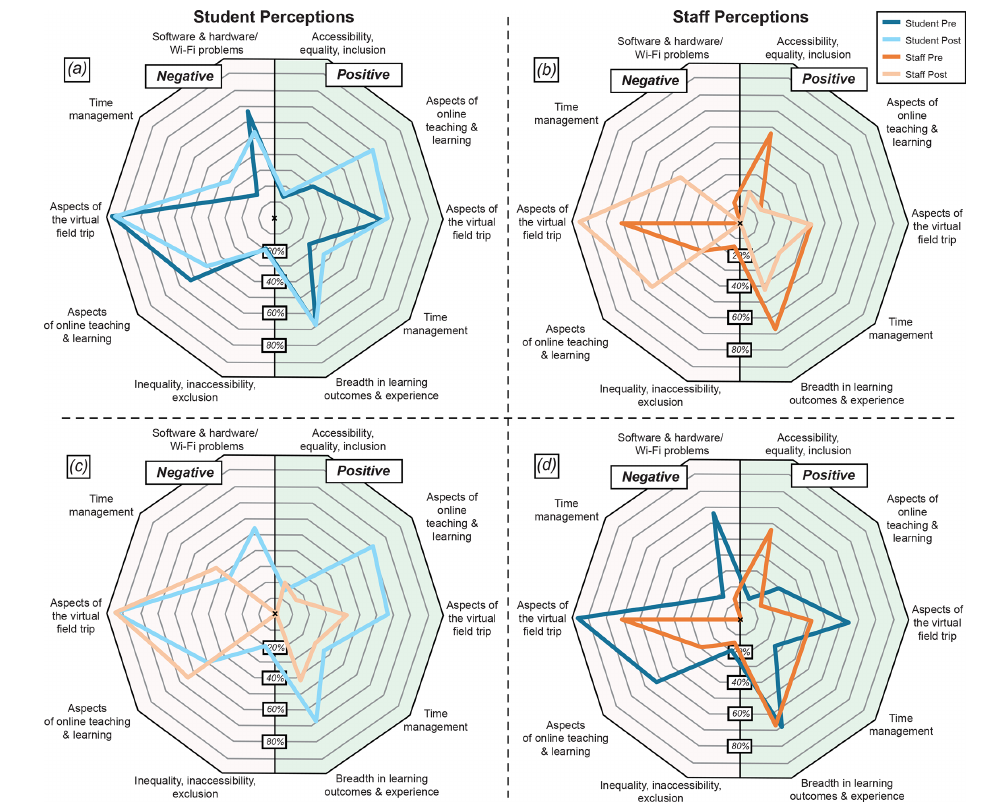
Figure 5. Radar plots of student and staff perceptions derived from free-text responses to questions: (a) student perceptions pre-course ( n = 20) and post-course ( n = 14), (b) staff perceptions pre-course and post-course ( n = 7), (c) comparison of student and staff perceptions pre-course, and (d) comparison of student and staff perceptions post-course. The plots are split vertically with negative elements on the left and positive on the right; the positive and negative equivalents are plotted opposite each other, except for two independent